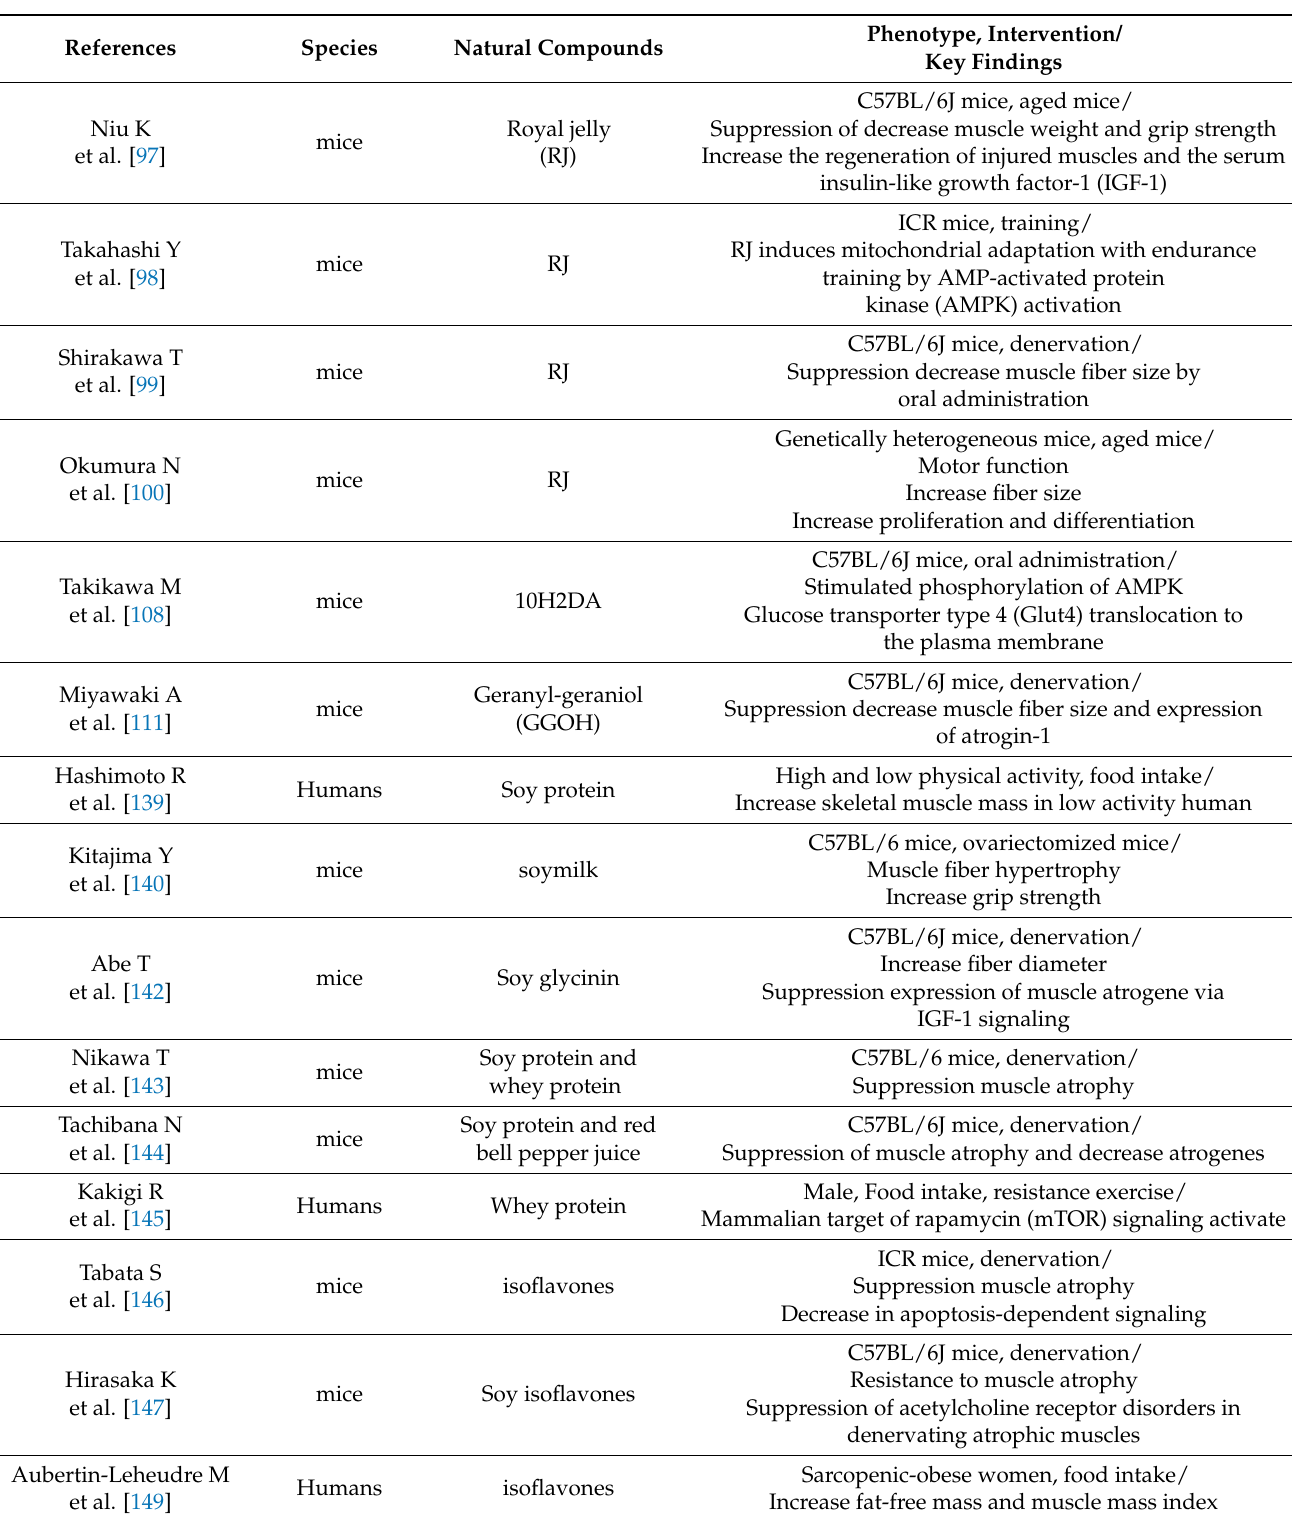
Table 2. Studies for the function of natural compounds on skeletal muscle